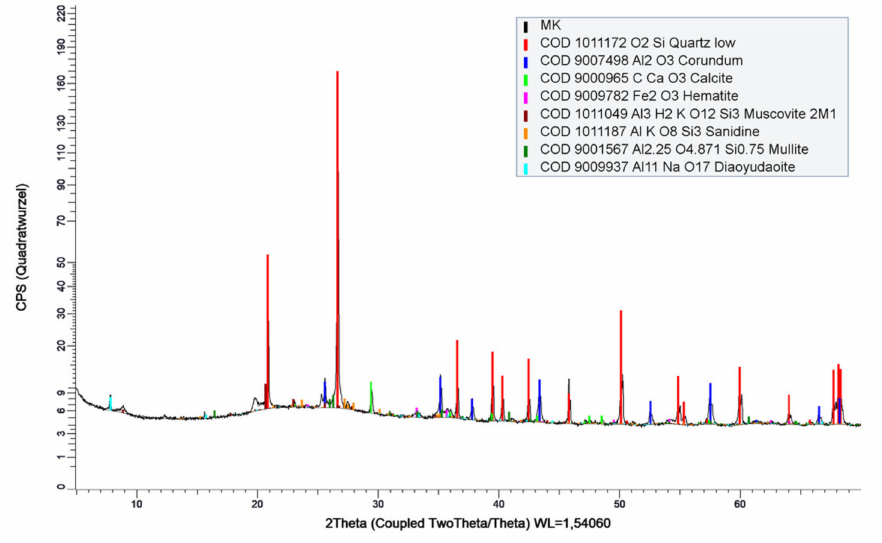
Figure 2. Powder X-ray diffractogram and qualitative analysis of metakaolin (MK2).